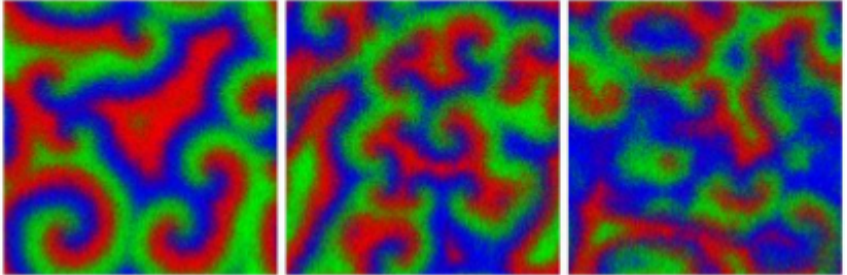
Figure 3. (Color online). Typical long-time snapshots in the BS ( left ), EI ( middle ) and AI ( right ) phases from stochastic simulations at low mutation rate. As in the next figures, each color represents one species (dark dots are regions of low density). The parameters are L = 128, N = 64, ( β , σ , µ , δ ) = ( 1,1,0.001,1 ) , and ζ = 0.6 ( left ), 1.2 ( middle ), and ζ = 1.8 ( right ), see text. In all panels, the initial condition is a random perturbation of the homogeneous state s ∗ , see text and [44]. Adapted from